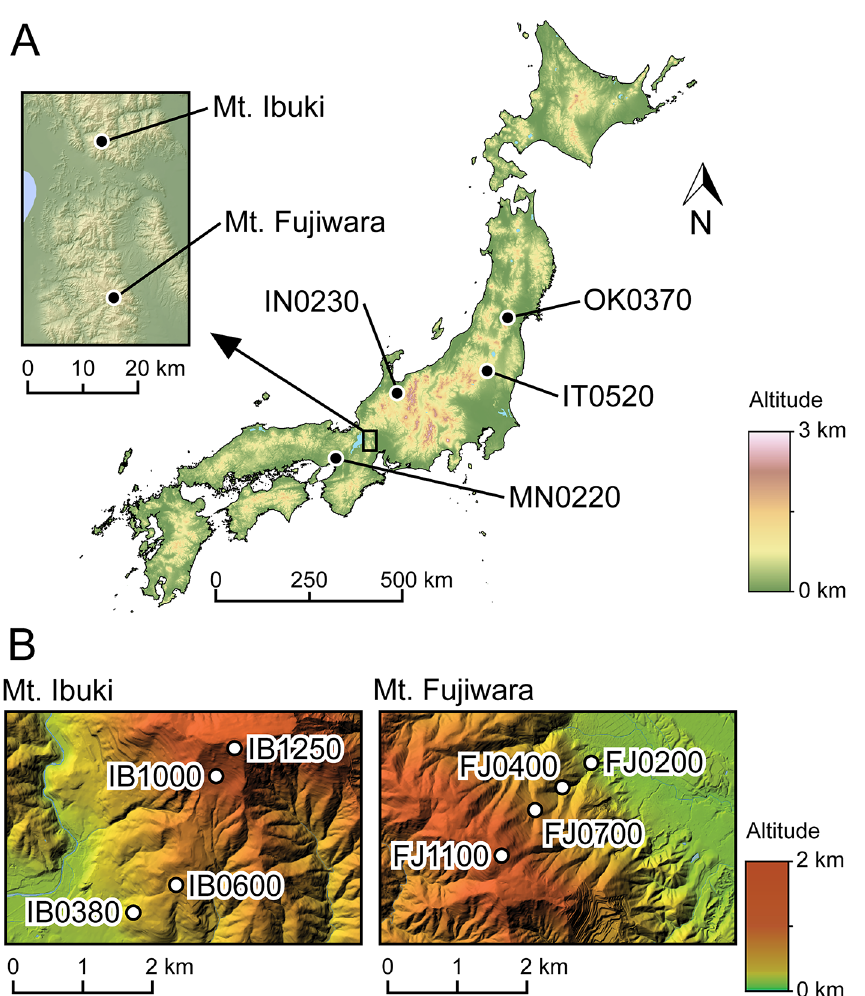
Fig 1. Location and of the studied populations. (A) Geographic locations of the two mountains (the main study sites) and the four low-altitude reference populations. Altitude is indicated by the numbers in the population names. See S1 Table for coordinates. (B) Locations of the four altitude-specific populations on each